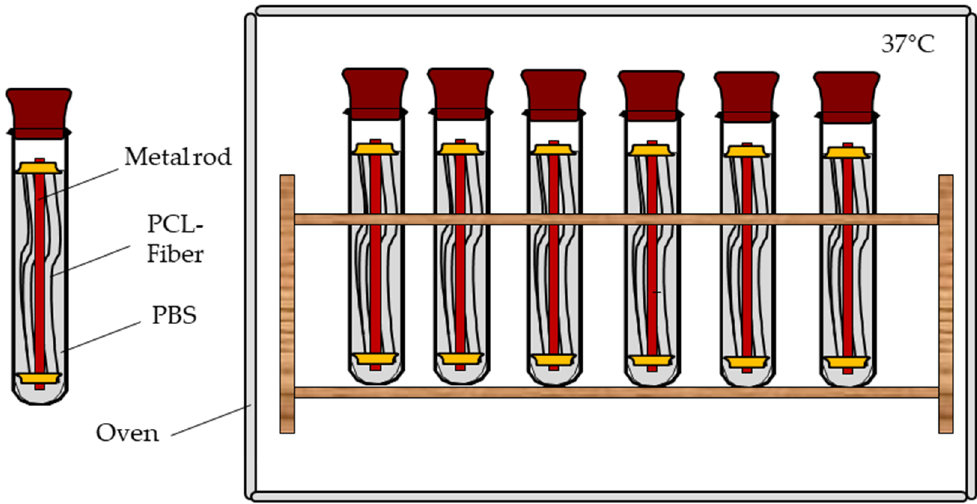
Figure 2. Polycaprolactone (PCL) fibers were fixated tension-free in glass vials. In each vial, five fibers were placed at once. The vials were filled with PBS and stored at 37 °C.